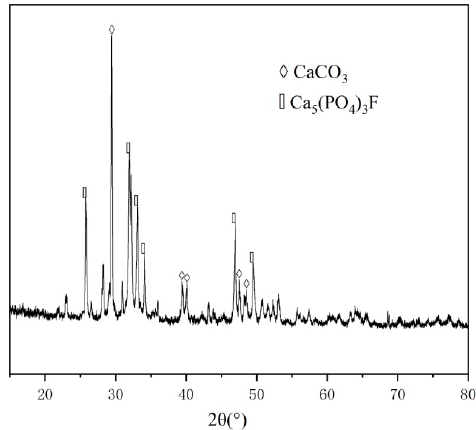
Figure 16. XRD pattern of the leaching residue.